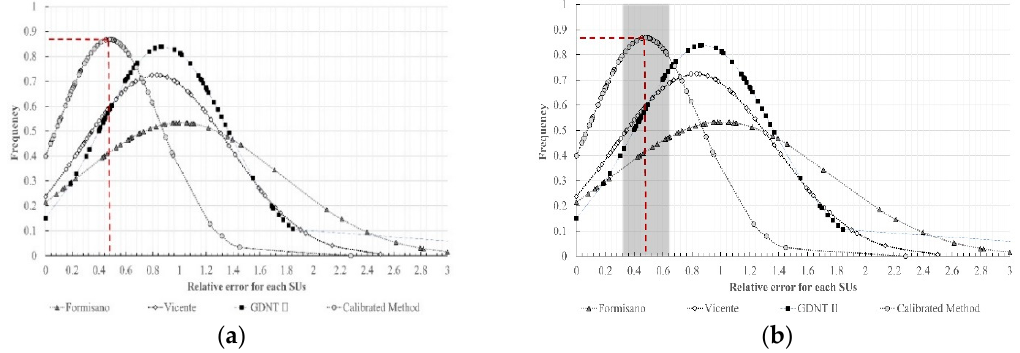
Figure 23. Relative error distribution of the I V methods obtained from the direct measure considering ( a ) the calibrated method and ( b ) the calibrated method with the IQ index. The grey area defines the confidence bounds for expected damage scenarios, i.e., the range of the relative error of the building stock analysed is on average between 0.3 and 0.7.